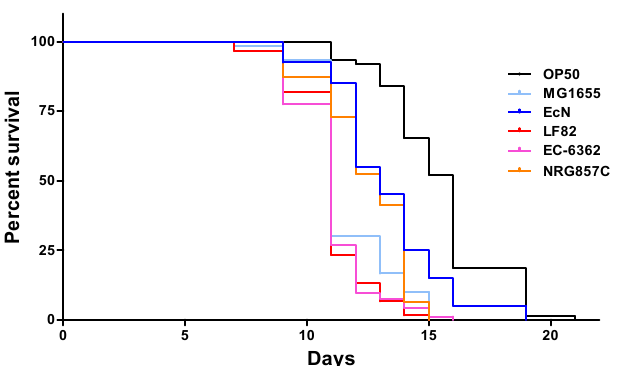
Figure 1. Kaplan–Meier survival plots of killing assays for C. elegans (N2) infected with six different E. coli strains. The “ n ” values in brackets correspond to the initial number of larvae investigated for each bacterial strain. L4 larvae were transferred to lawns of OP50 (the control strain: n = 84), MG1655 ( n = 74), EcN ( n = 45), LF82 ( n = 78), EC-6362 ( n = 101), and NRG857C ( n = 65).